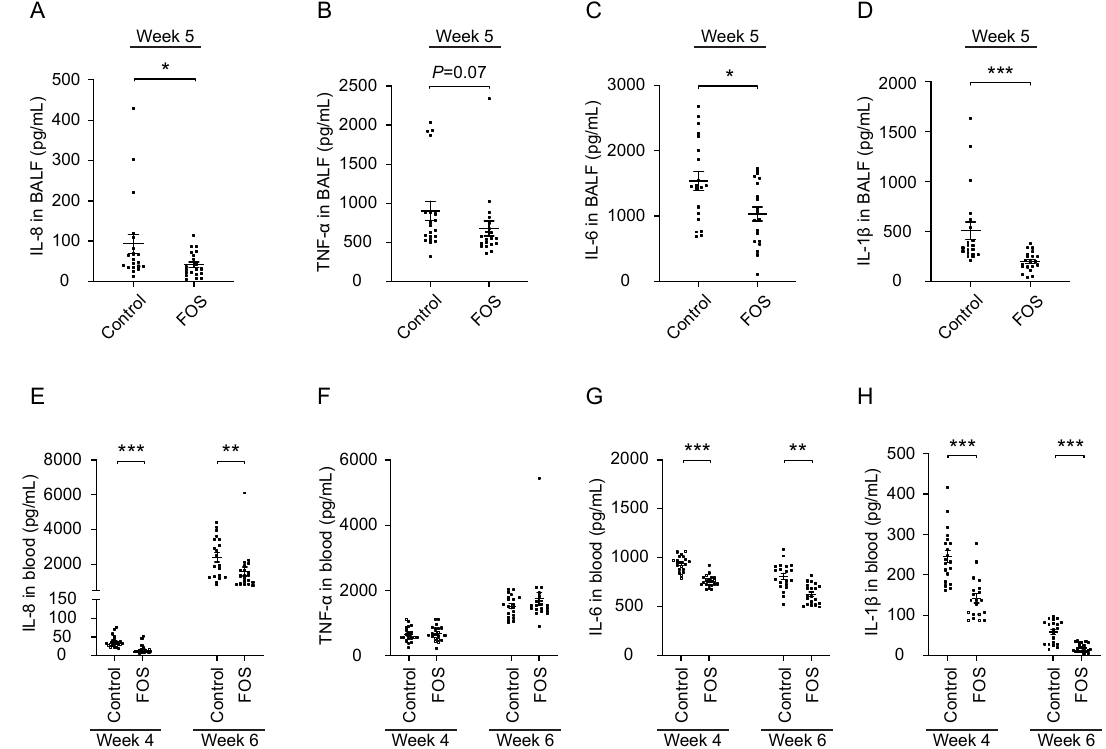
Figure 2. Effect of FOS on cytokine/chemokine concentrations in BALF and blood of calves. ( A and E ) IL-8, ( B and F ) TNF- α , ( C and G ) IL-6, and ( D and H ) IL-1 β concentrations in BALF and blood were measured for a subset of calves ( n = 40, 20 calves/treatment). Significantly different from control at that time: * p < 0.05; ** p < 0.01; *** p < 0.001. Data are presented as means ± SEM. Each dot represents one calf. BALF, bronchoalveolar lavage fluid; FOS, fructo-oligosaccharides; IL, interleukin; TNF, tumor necrosis